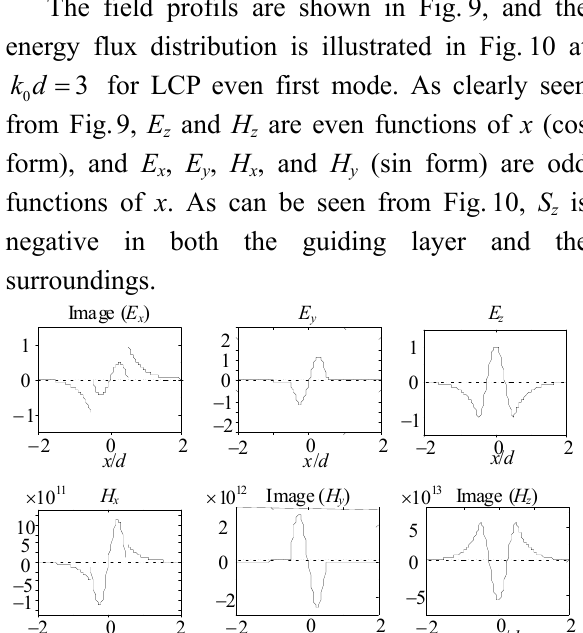
Fig. 8 Energy flux at m = 0.